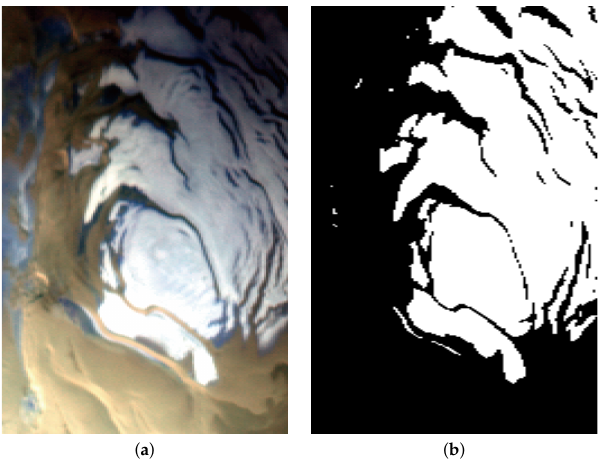
Figure 5. ( a ) OMEGAORB0041image of the south pole of Mars. (R-band 100, G-band 50 and B-band 24); ( b ) ROI (in white), where the GRSIR has computed the physical parameters of the chemical